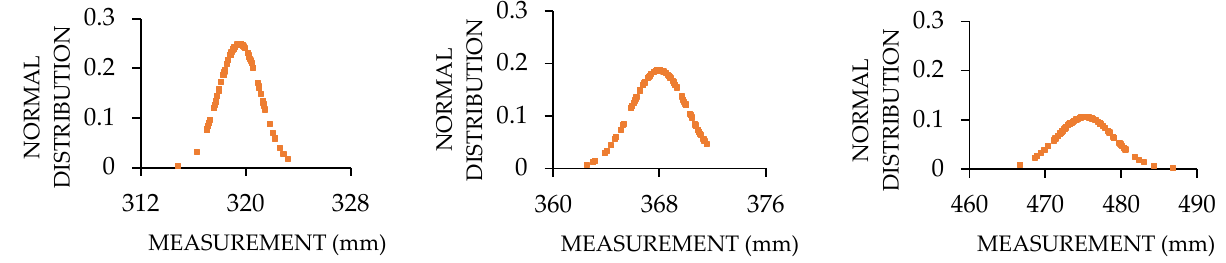
Figure 12. The normal distribution function of VL53L0X for tests with ambient light. Table 4. Statistical analysis of VL53L0X for tests with ambient light.